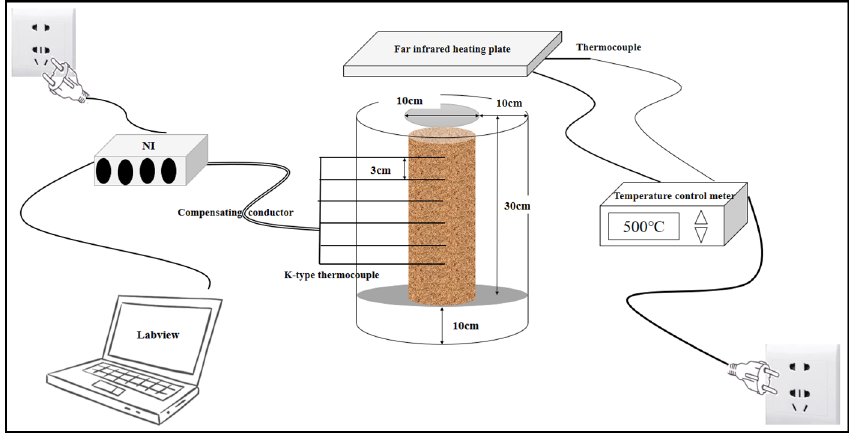
Figure 2. The design of the simulated smoldering experimental equipment.